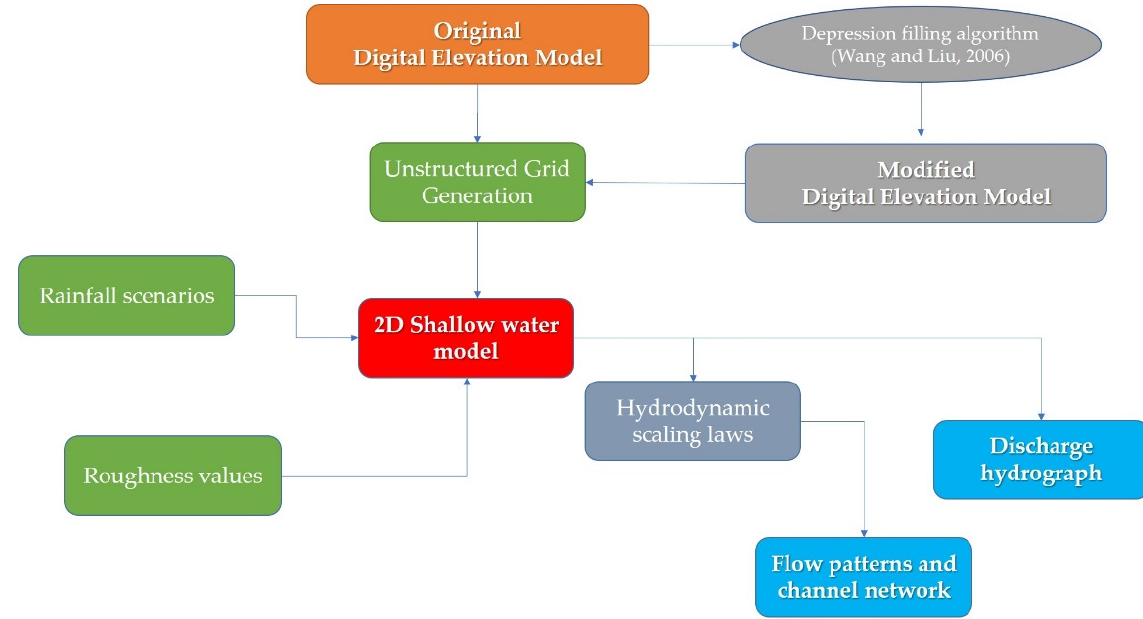
Figure 2. Flow chart illustrating the methodology used in this work.